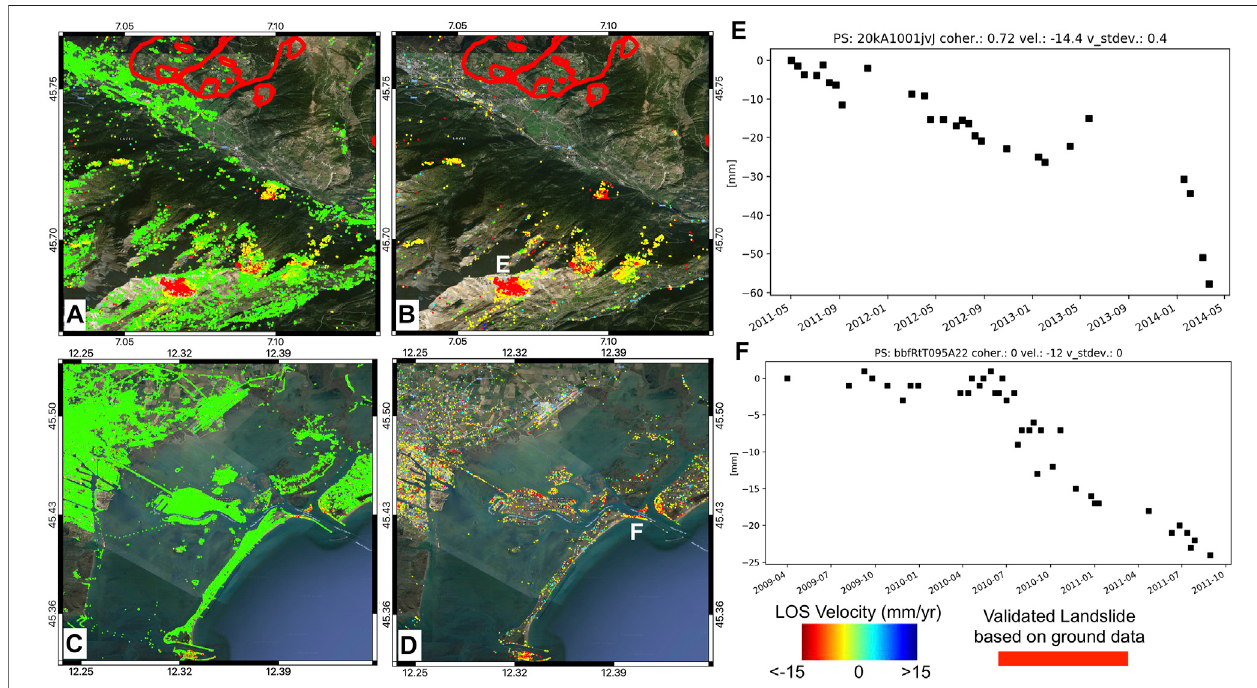
FIGURE4| Examplesofmulti-temporaltime-seriesdatasetoverdifferentruralandurbanenvironments: (A) CSKdatasetoverAostaValley.Redpolygonsshowthe location of the ground-based validated dataset from Di Martire et al. (2017) used as training dataset. In this speci fi c case, the landslide polygon is covered by only few measurement points. The ground-based procedure failed to identify the landslide area located southern close to lon 7.05 lat 45.7 coordinates whereas the proposed neural network approach identi fi es the same area as signal. (B) Neural network signal prediction over Aosta Valley; letter E in panel (B) refers to a time-series point shown in panel (E) . (C) CSK dataset over the city of Venice. (D) Time series of anomalous points predicted as signals by the neural network approach presented in this paper;letterFinpanel (D) representsthelocationofthetimeseriesshowninpanel (F) . (E) Timeseriesofdisplacementrelatedtoanareacharacterizedbyanaccelerating landslide shown in panel (B) . (F) Anomalous time series related to an area located close to Venice port exit.